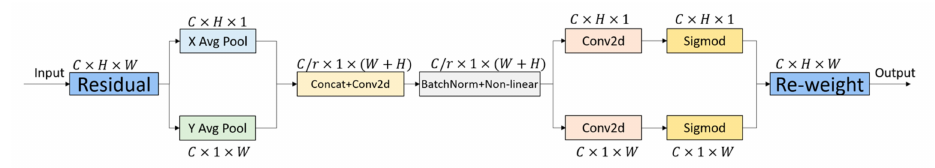
Figure 6. Schematic of the CA